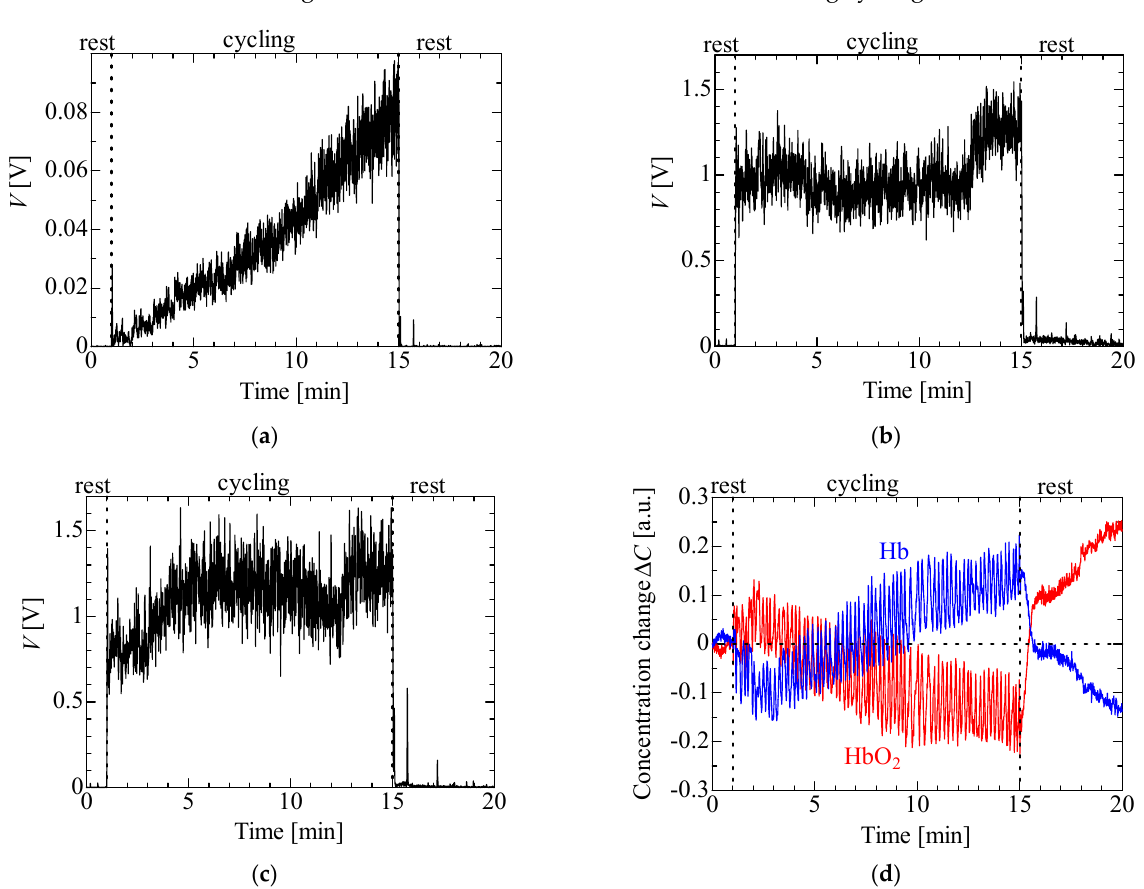
Figure 8. Experimental results for isometric ramp contraction: ( a ) EMG, ( b ) MMG (LED), ( c ) MMG (PD) and ( d ) NIRS.